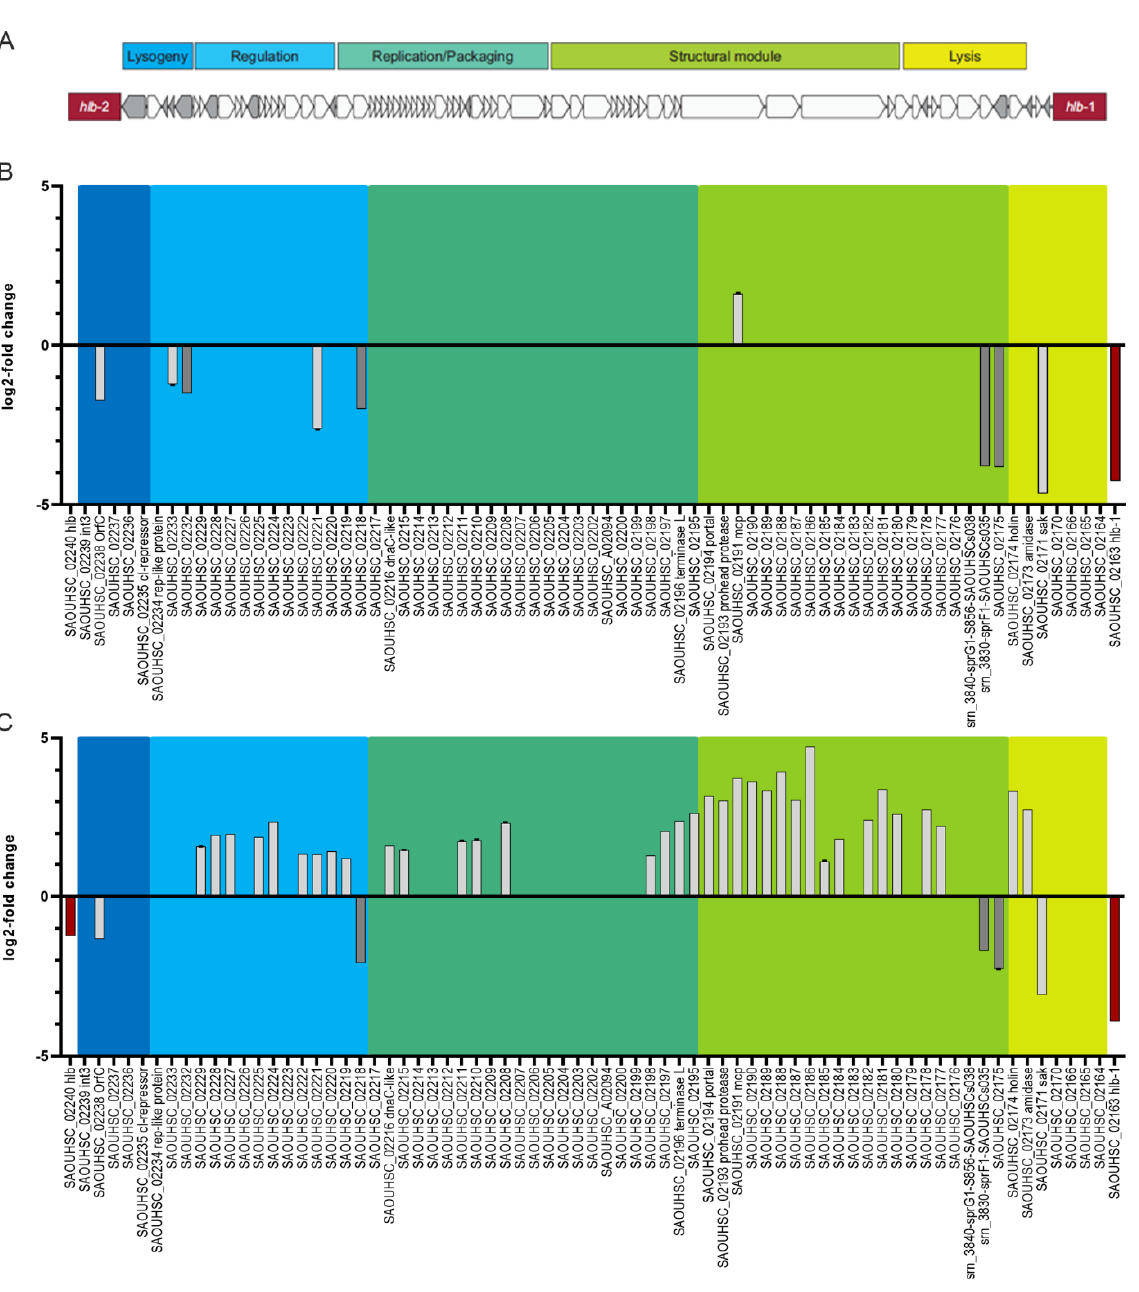
Figure 6 . Module organization of Ф 13kan ( A ). Comparison of Ф 13kan- Δ rep gene expression between MW2- and 8325-background under uninduced conditions ( B ) and after mitomycin induction ( C ). Only genes with significant differences in gene expression are shown (FDR-value < 0.05; log2fold change >+1 and < − 1). Negative values represent higher expression in 8325 background; positive values represent higher expression in MW2 background.